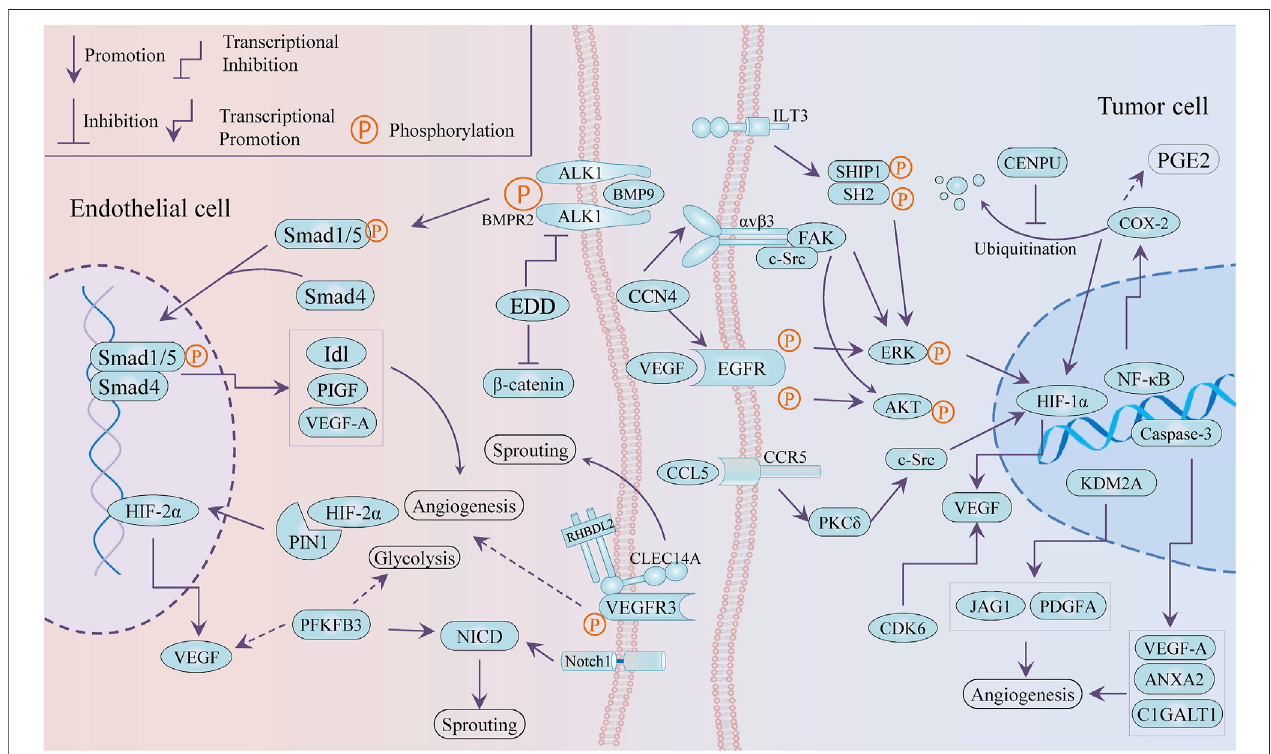
FIGURE 2 | Schematic draw of potential targets against